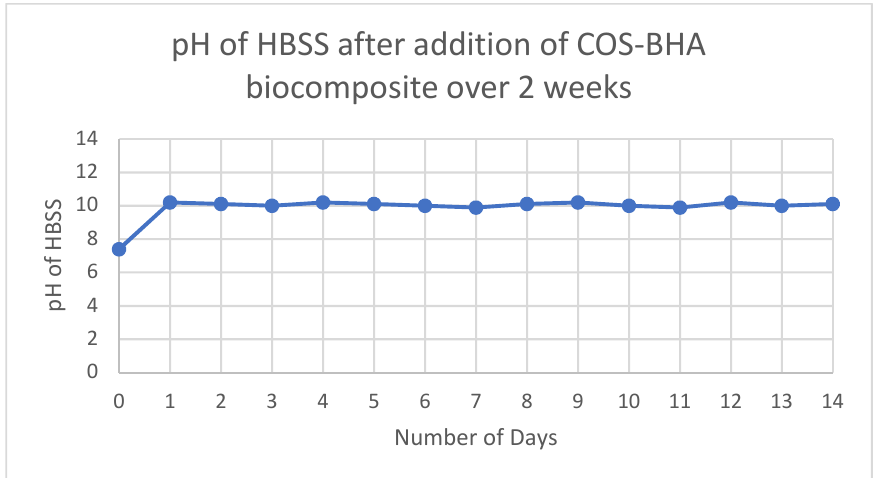
Figure 3. pH of HBSS over 2 weeks following the addition of the experimental pulp-capping agent.